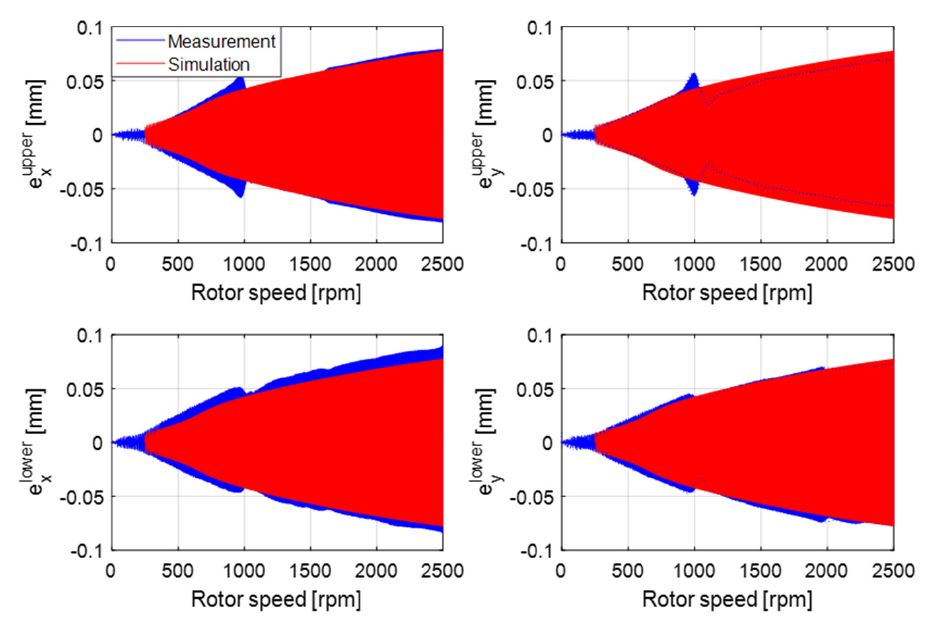
Figure 17. The simulated and measured displacements of the shaft with 5.9 × 10 − 3 kg · m unbalance magnitude and 2 π rad/s 2 angular acceleration.